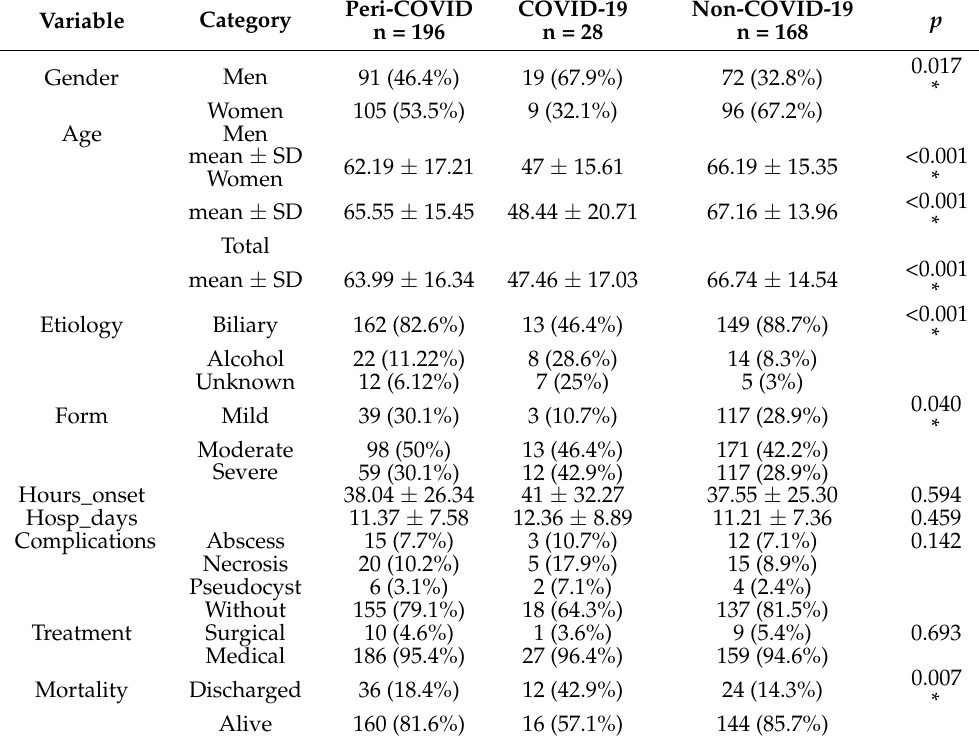
Table 3. Demographic characteristics of patients with AP and COVID-19 in the peri-COVID